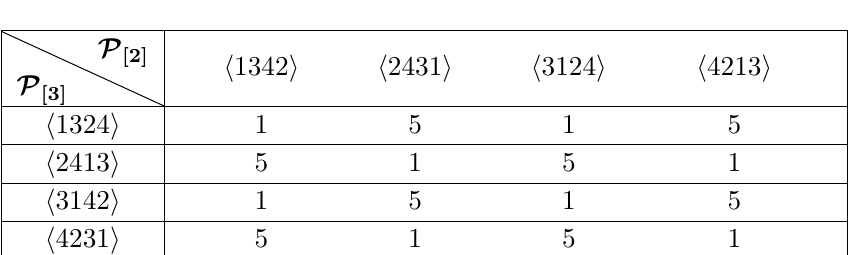
Table 20. {P} 3 − {P} 2 two-point correlator values.